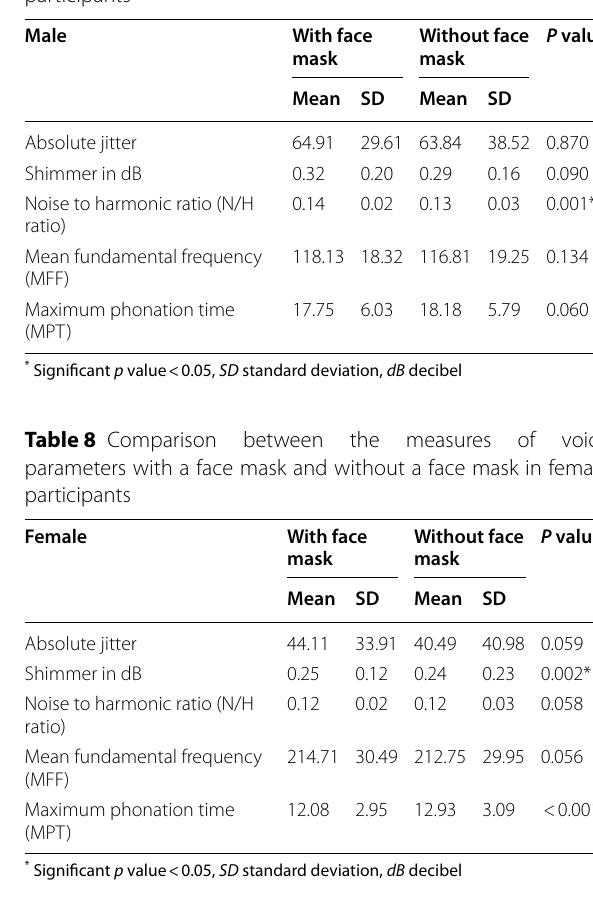
Table 7 Comparison between the measures of voice parameters with a face mask and without a face mask in male